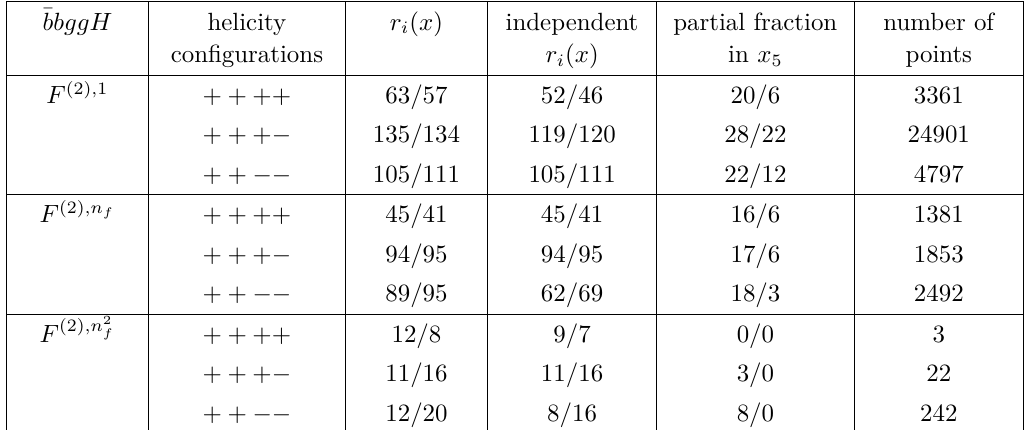
Table 1. Maximum numerator/denominator polynomial degrees of the finite remainder coefficients r i ( x ) in eq. (3.3) at each stage of our reconstruction steps, together with the number of sample points needed for the analytic reconstruction in the ¯ bbggH subprocess, for the various closed fermion loop